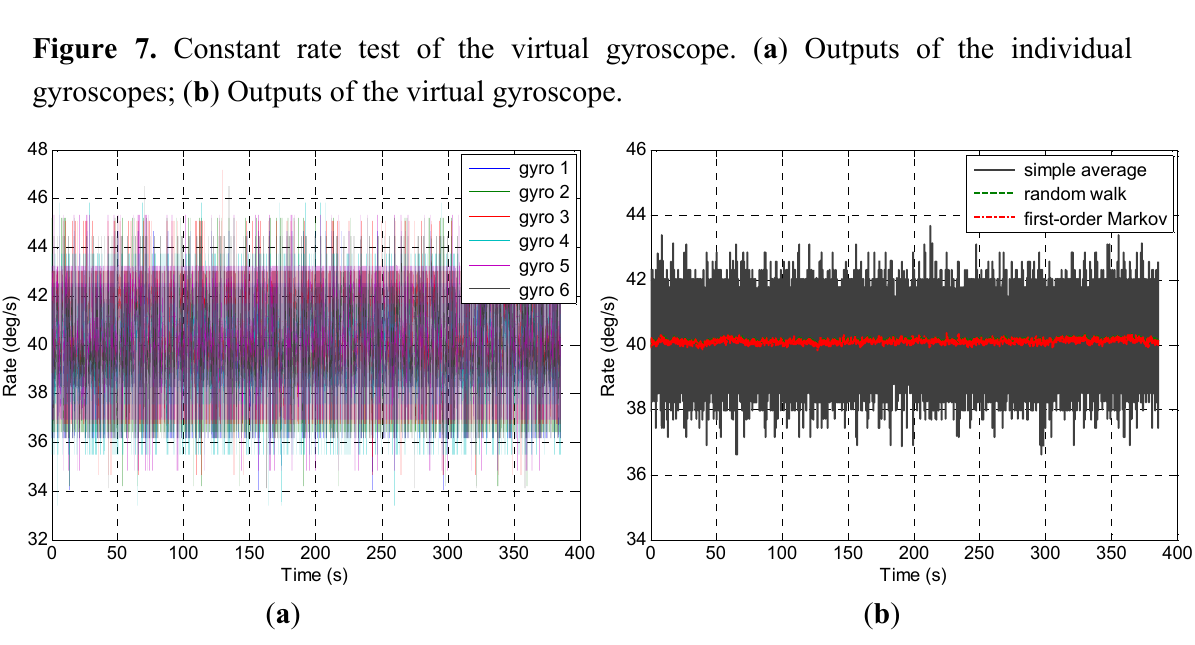
Figure 8. Random rate test of the virtual gyroscope. ( a ) Outputs of the individual gyroscopes; ( b ) Outputs of the virtual gyroscope; ( c ) Estimated rate